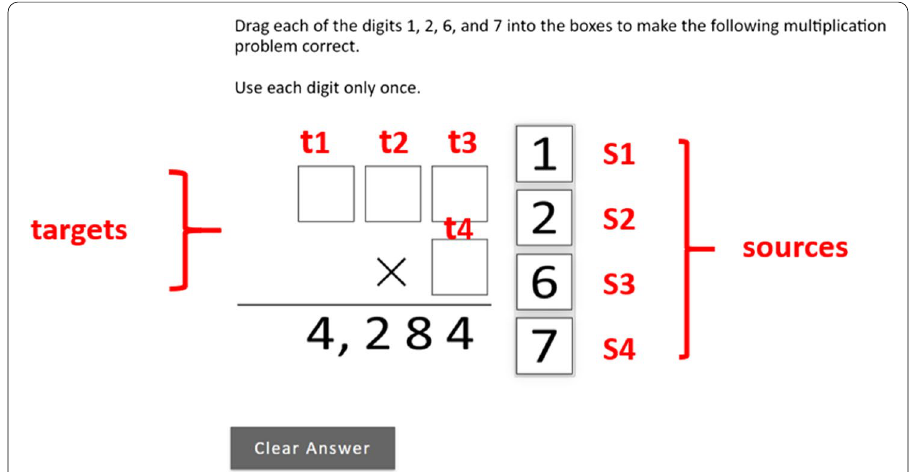
Fig. 3 Screenshot of a released drag‑and‑drop item administered to eighth‑grade students (G8 item) in the 2017 NAEP mathematics assessment. The sources and targets are denoted in